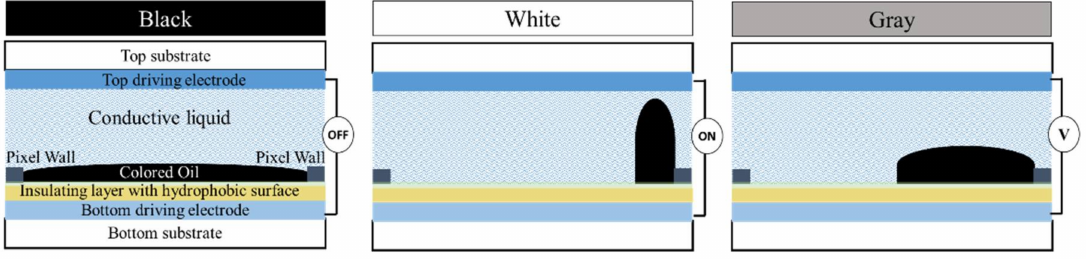
Figure 3. Device structure and working principle of the electrowetting